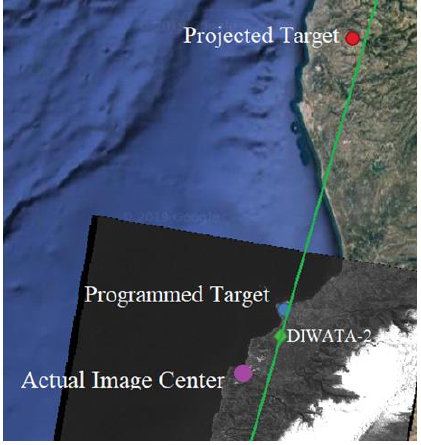
Figure 1. Tripoli, Lebanon. Relative positions.